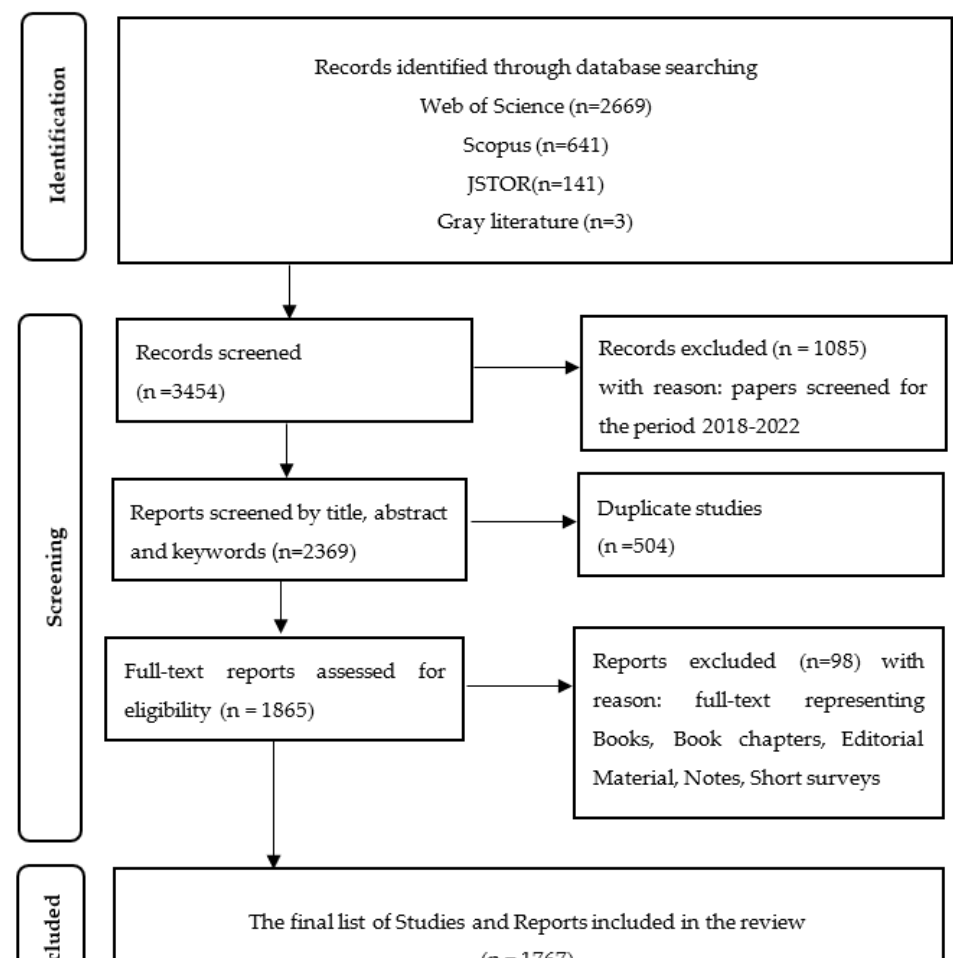
Figure 1. PRISMA flowchart of literature review process based on the combined search of two keywords: social innovation and energy transition. As shown, from a total of 3454 records initially retrieved, only 1767 records were included. All these articles were published during 2018–2022 in English.